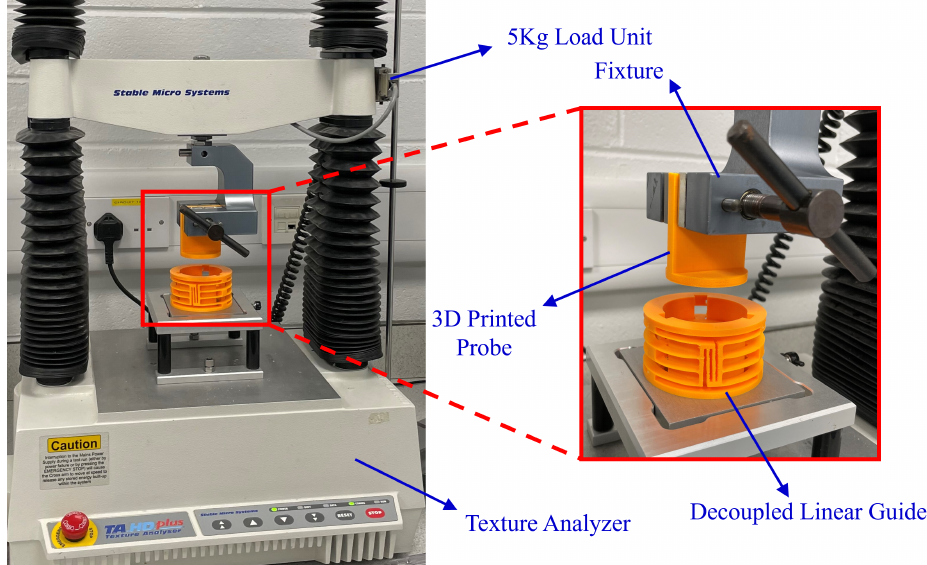
Figure 10. The experimental setup.